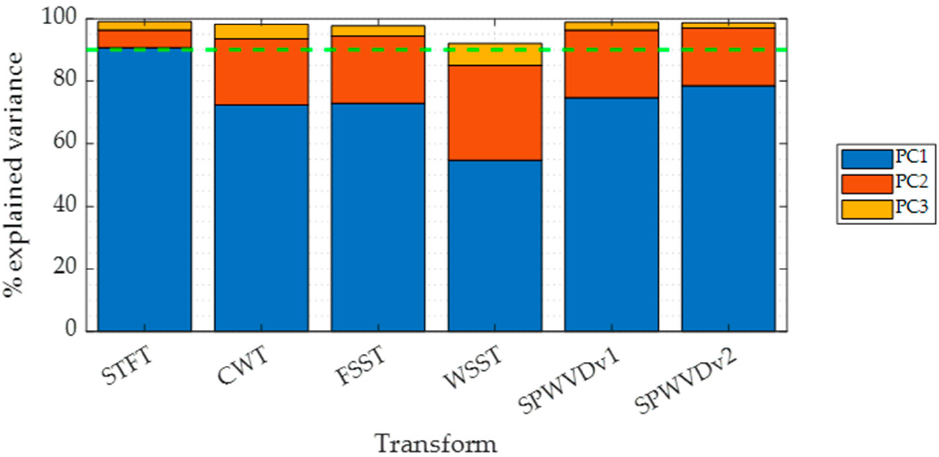
Figure 8. Explanation of variability by first three principal components for each transformation. The green horizontal line marks the 90% level of variability in dataset.